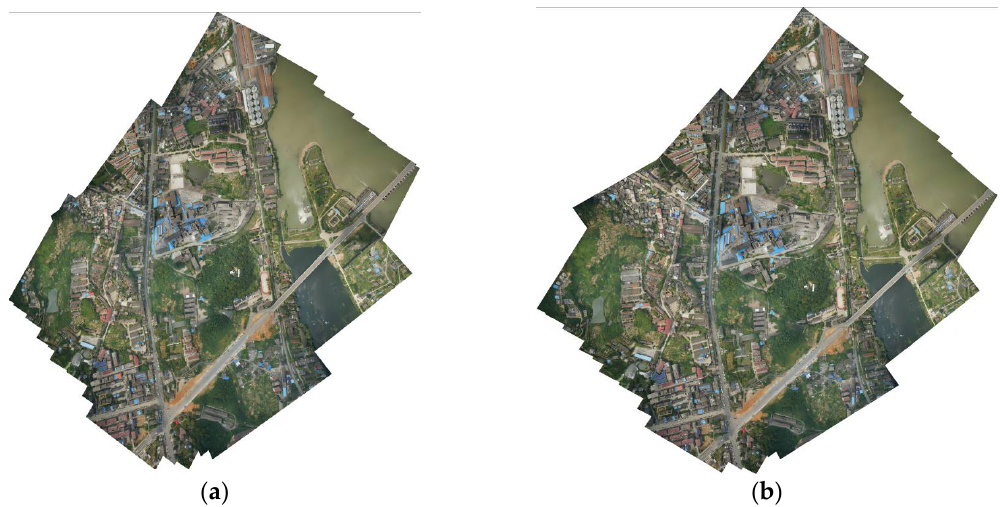
Figure 5. Mosaicking result of Dataset 1: ( a ) mosaicking result via Capel’s method; and ( b ) mosaicking result using the proposed algorithm.